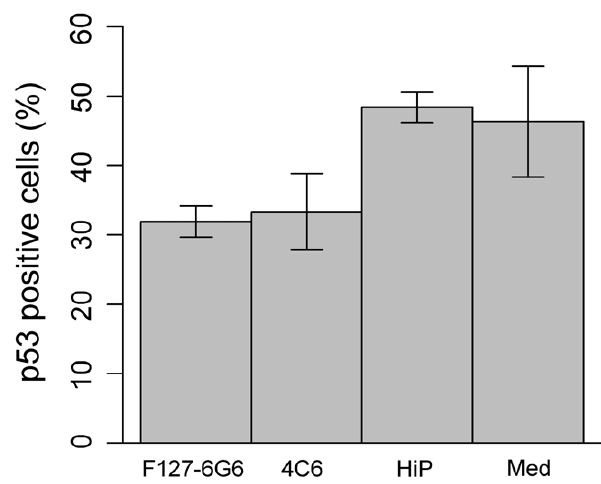
Figure 6. Average quantity of p53 per cell following chemical transfection with 40 m g/mL F127-6G6 E6 antibody. p53 quantity is evidenced by intensity of p53 staining. Cells transfected with the antibody show a higher quantity of p53 per cell (i.e. a higher intensity of p53 staining) after 48 hours than those in control wells treated with only the HiPerFect (HiP) transfection reagent or culture medium (Med) alone ( P =0.005, P , 0.001, n= 3 for both). Also, SiHa cells showed a greater quantity of p53 per cell than CaSki ( P , 0.001, n= 3). Statistical analysis was performed using a two-way ANOVA followed by Tukey HSD contrast tests post hoc. Error bars represent mean + / 2 SEM. ‘‘*’’